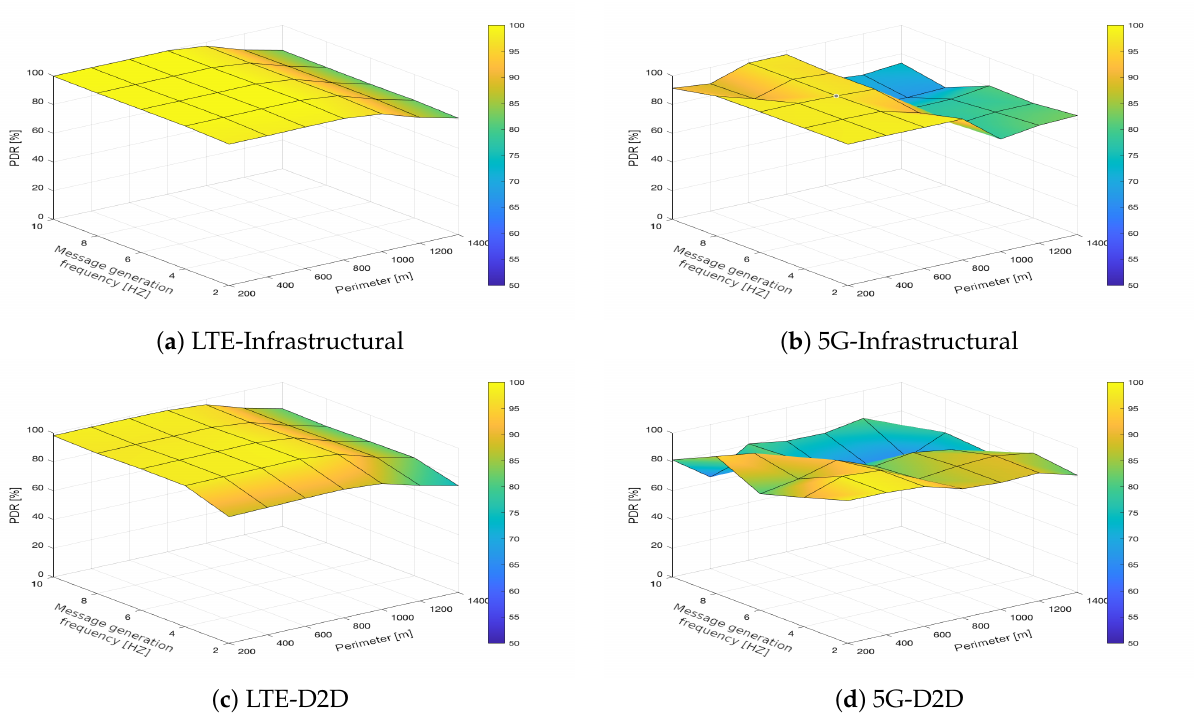
Figure 6. PDR simulated for all the investigated modes of the 4G-based and 5G-based C-V2X technologies and traffic intensity of 1250 vehicles per